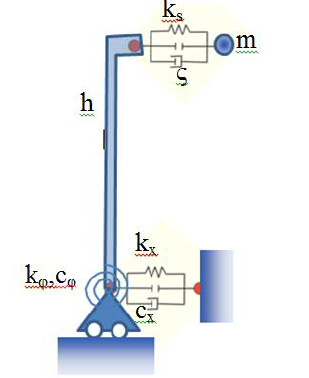
Figure 6. Three-DOF dynamic system representing